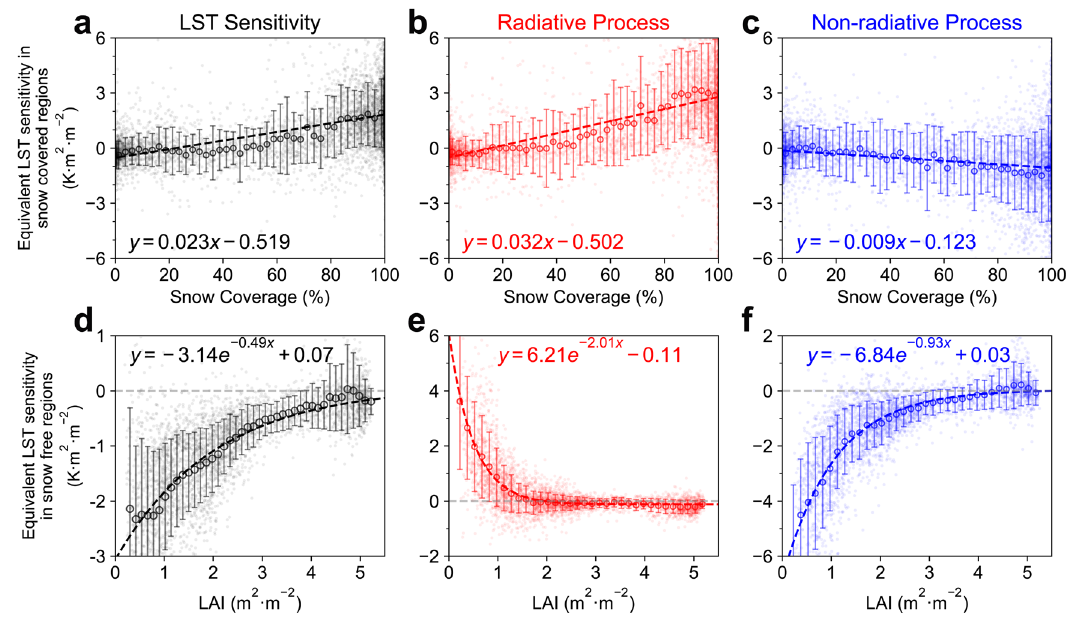
Fig. 4 | Impacts of snow coverage and leaf area index (LAI) on the local bio- physical feedbacks. a The relationship between mean snow coverage and land surface temperature (LST) sensitivity and the equivalent LST sensitivity from ( b ) radiative process and ( c ) non-radiative process in snow-covered area (snow cov- erage that is greater than 1%) from January to April. Error bars show the standard